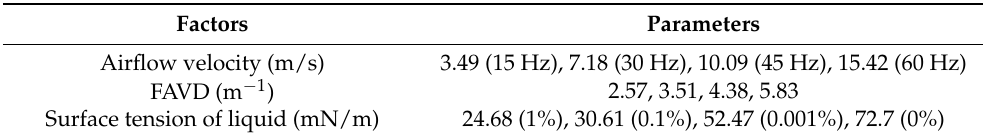
Table 7 . Factors and corresponding parameters for conducting experiment of droplet attenuation in canopies.